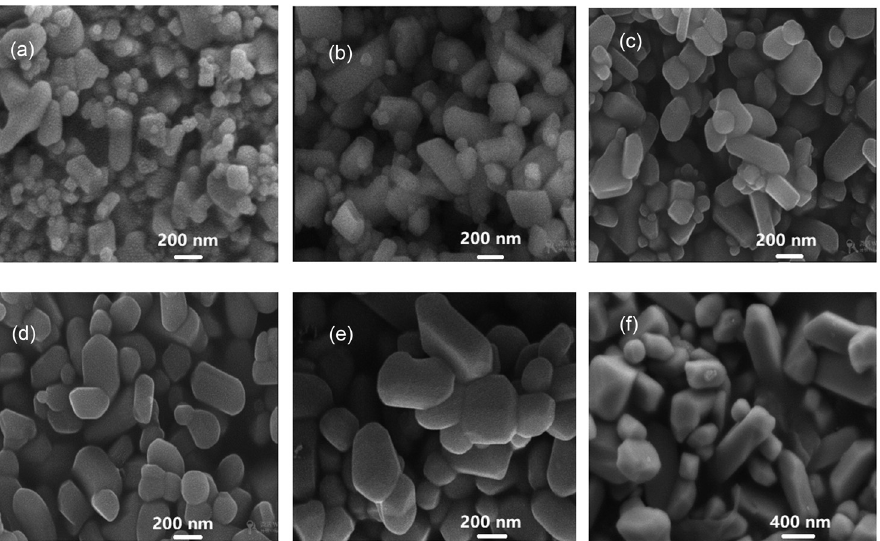
Figure 5: Morphology changes and crystal growth of metatitanic acid during calcination. ( a ) 800°C, ( b ) 830°C, ( c ) 845°C, ( d ) 850°C, ( e ) 900°C, ( f ) 1000°C.